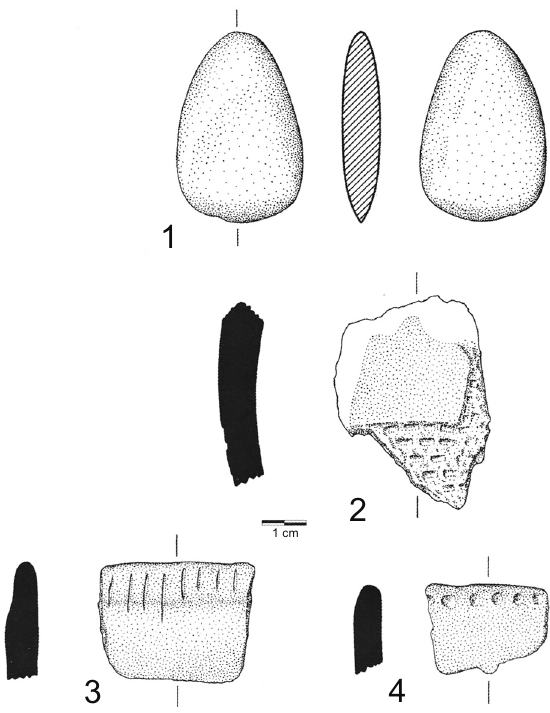
Figure 12: Decorated ceramic sherds and polished axe from SU - 2 ( adapted from Meireles, 2010, p. 93 )